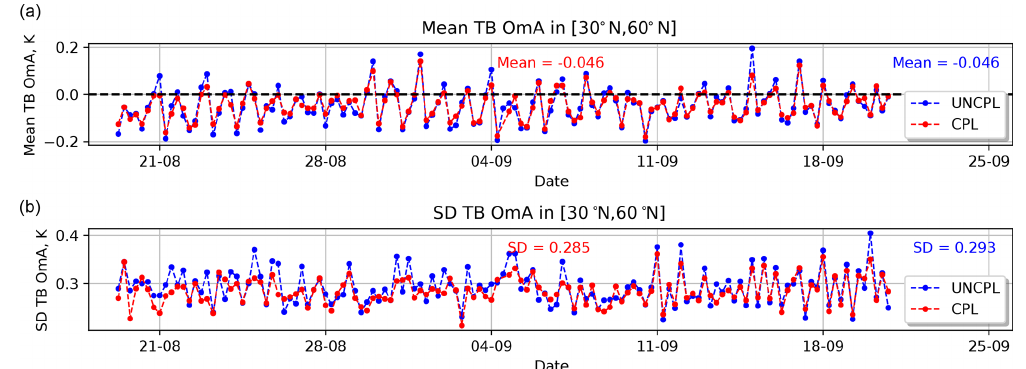
Figure 4. (a) Observation-minus-analysis (OmA) statistics: mean (a) and standard deviation (b) using 6h forecasts. Mean and standard deviation for the brightness temperature (K) as seen by the AQUA AIRS channel 950. The statistics are computed for UNCPL (blue) and CPL (red) in the northern extratropics region between 30 and 60 ◦ N.